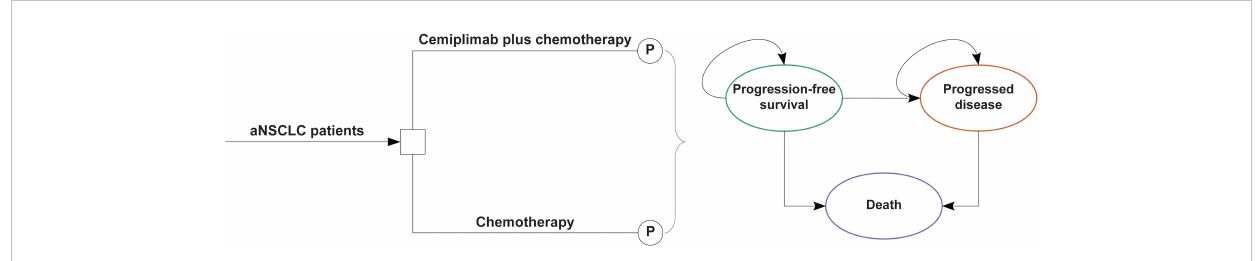
FIGURE 1 The partitioned survival model consisting of three discrete health states. aNSCLC, advanced non-small cell lung cancer; P indicates partitioned survival